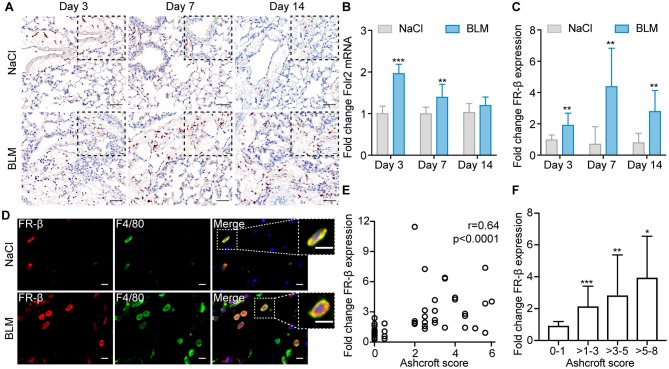
FR-β expression is increased in experimental ILD and correlates with the severity of lung remodeling. (A) Representative images of lung sections from saline-treated controls and BLM-treated mice at days 3, 7, and 14 stained for FR-β (red). Representative pictures at 100× magnification (scale bars: 100 μm) and at higher magnification (400×, scale bars: 20 μm) are shown. (B) Fold change of mRNA expression of Folr2 in BLM-treated mice vs. saline-treated controls at days 3, 7, and 14. (C) Semi-quantification of FR-β tissue expression by automatic image analysis. (D) Representative images of immunofluorescent double staining of FR-β (red) with the murine macrophage marker F4/80 (green) performed on lung sections from saline-treated controls and BLM-treated mice at day 7. For (D) representative images from three mice each at 630× magnification are shown (scale bars: 10 μm). (E) Spearman correlation of FR-β expression with the Ashcroft score. (F) Analysis of FR-β expression according to the severity of lung remodeling as defined by the Ashcroft score (score 0–1: no fibrosis, scores >1–3: mild fibrosis, scores >3–5: moderate fibrosis, scores >5–8: severe fibrosis). For (B,C,F) data are presented as medians ± IQR. For statistical analysis the Kruskal–Wallis test with Dunn's multiple correction or the Mann–Whitney U-test was applied (*p < 0.05, **p < 0.01, ***p < 0.001). For all experiments: n = 6 for saline-treated controls, n = 9–10 for BLM-treated mice.